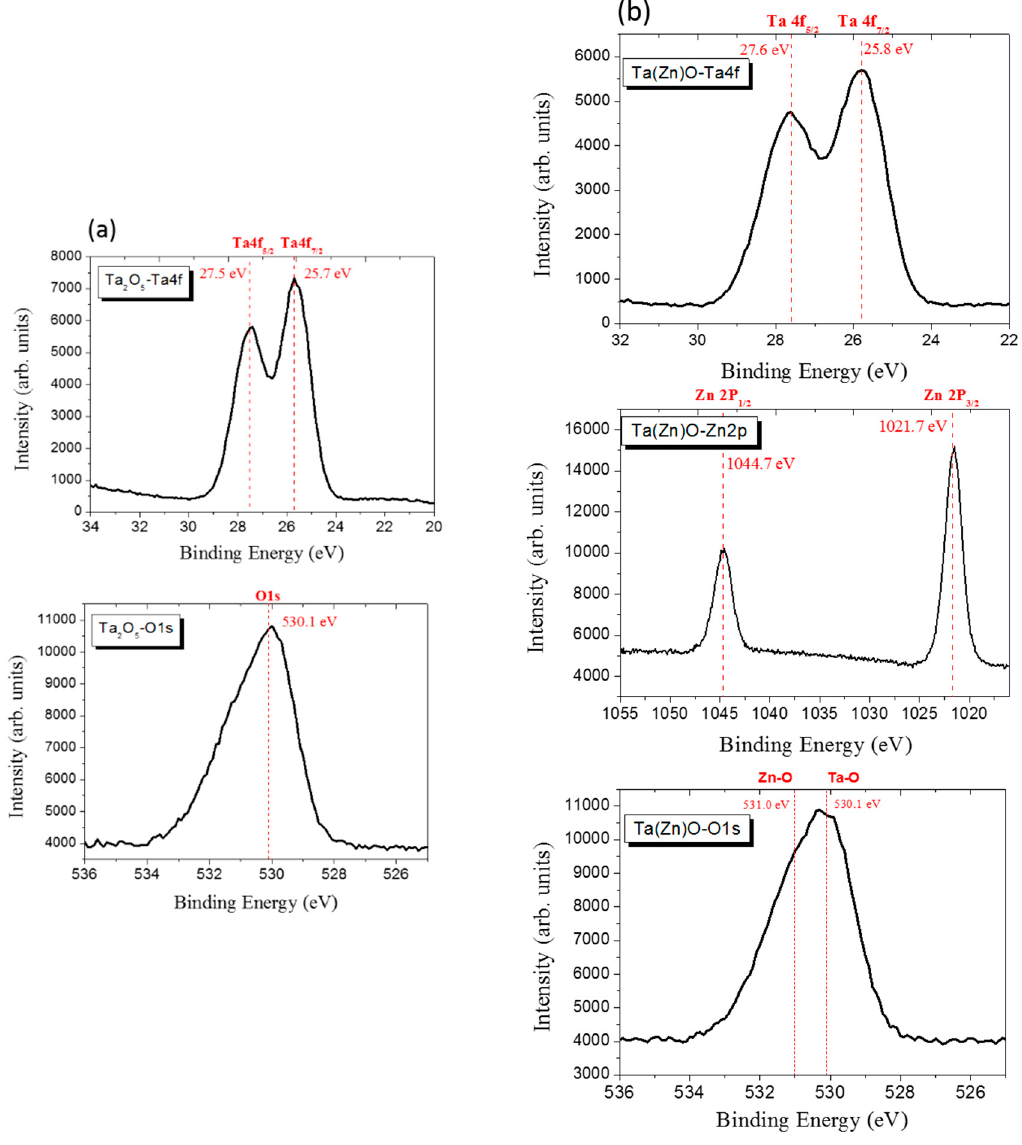
Figure 4. The Ta4f, Zn2p and O1s core level XPS spectra of the ( a ) Ta 2 O 5 and ( b ) Ta(Zn)O thin film on Ti.